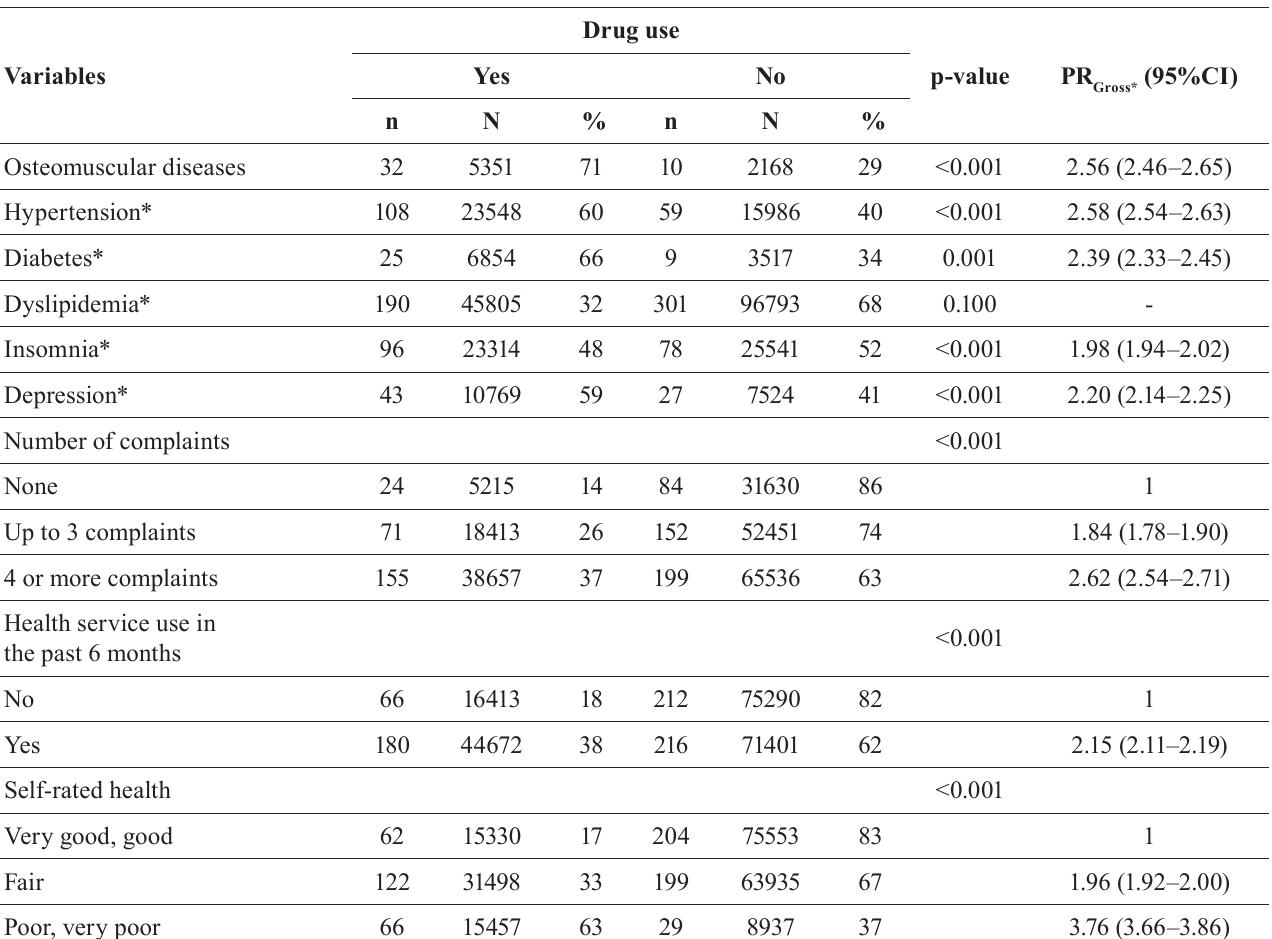
TABLE III - Prevalence and crude PR of medicine use according to health conditions of the adult population in Rio Branco, Acre, Brazil, 2014